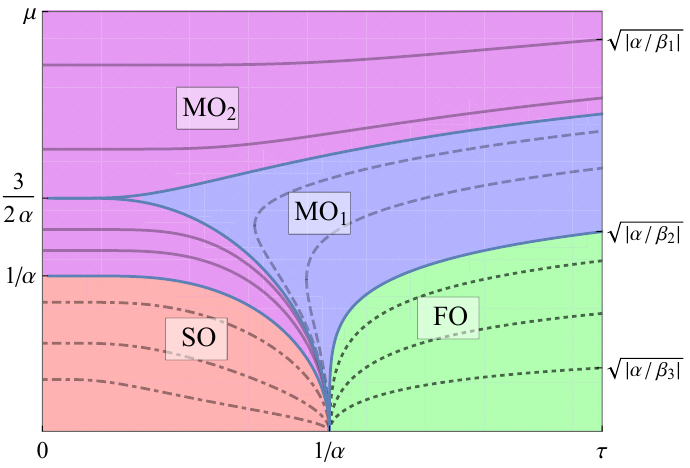
Figure 1. (Color online) The peculiar µ – τ phase diagram representing solutions of the master Equation (8) given a fixed value for α and different values for β (see text for